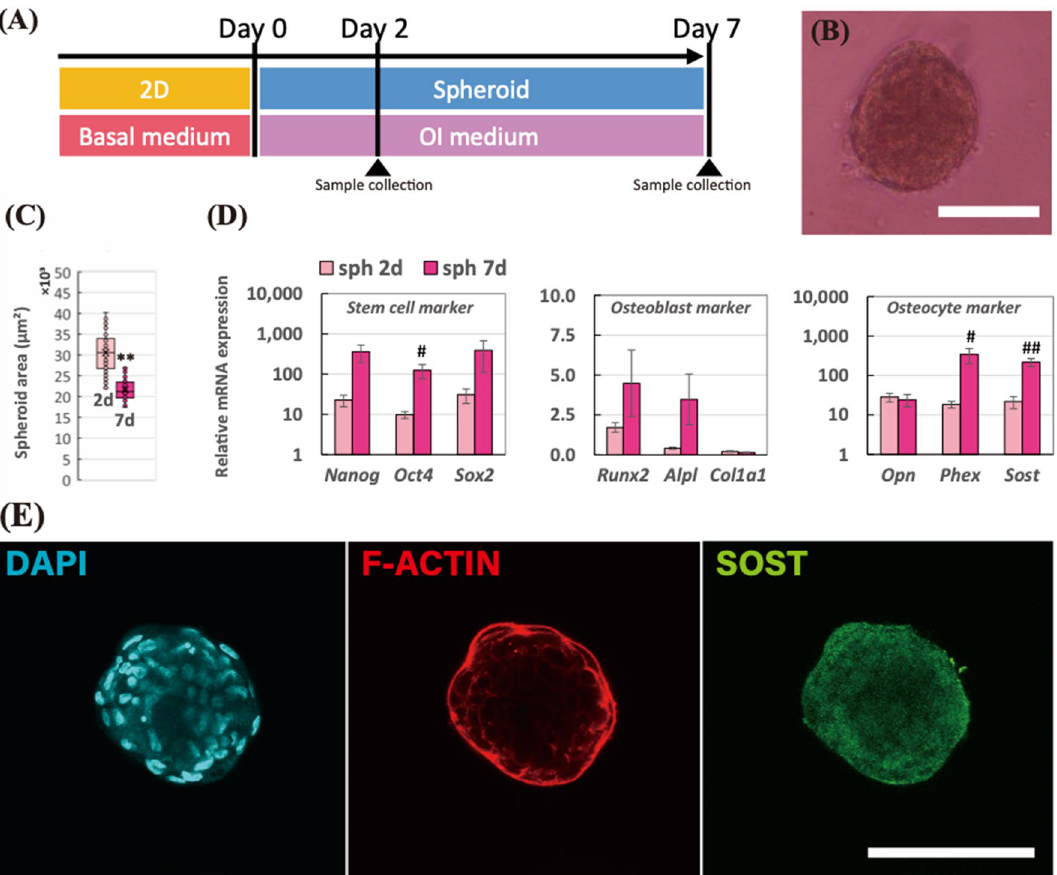
Figure 2. ( A ) Schematic of the experimental time line for spheroids incubated in the osteogenesis induction medium for 7 days. ( B ) Morphology of the spheroid after a 7-day incubation period. The scale bar represents 100 μm. ( C ) Mean values of projected area of the spheroids after 2 and 7 days. F-test was performed to examine the significance of area changes in spheroids ( n = 60 from 5 independent experiments; * p < 0.05, ** p < 0.005). ( D ) Relative mRNA expressions of stem cell markers ( Nanog , Oct4 , and Sox2 ), osteoblast markers ( Runx2 , Alpl , and Col1a1 ), and osteocyte markers ( Opn , Phex , and Sost ) in the spheroids at 2-day and 7-day incubation were measured by real-time PCR. All the mRNA expressions were normalized to Gapdh expressions while the results were expressed as relative amounts against the expression of monolayer sample ( n = 8). The bars represent the mean ± standard error. P -value was calculated from Student’s t -test; # p < 0.05, ## p < 0.005. ( E ) Immunostaining images of spheroid after 2-day incubation; cell nuclei (DAPI in cyan), actin filaments (F-actin in red), and sclerostin (SOST in green). The scale bar represents 100